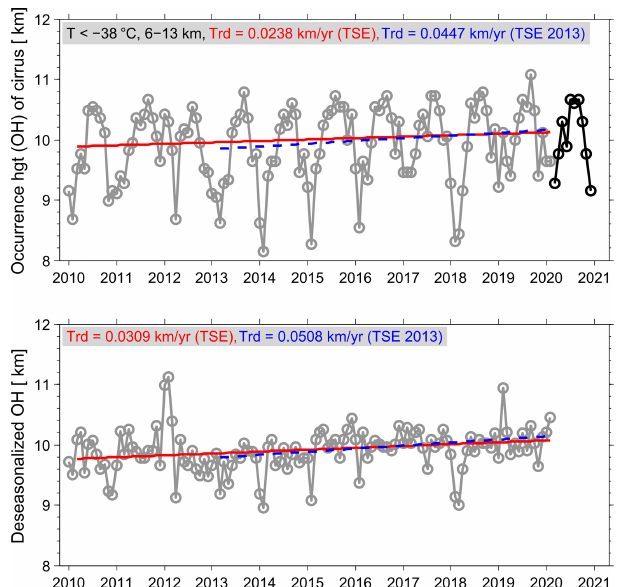
Figure 7. Same as Fig. 6, but for the long-trend variations of the occurrence heights of cirrus clouds for both day- and night-time observations during the period from March 2010 to February